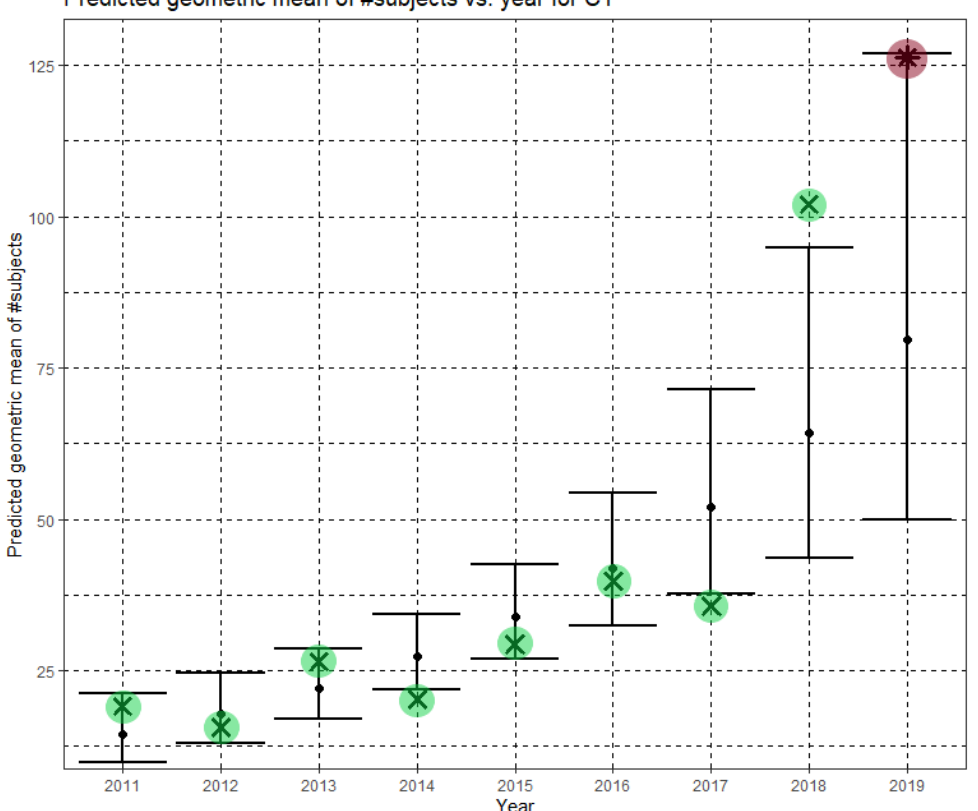
Figure 5. Phase I—Predicted geometric mean (black dots) and confidence intervals of dataset sizes in MICCAI articles involving CT for the years 2011–2019, based on the whole ensemble of 2011–2018 CT dataset sizes. The empirical geometric means (2011–2018) are shown (in green) for comparison (x marks). The empirical geometric mean for 2019 (in purple) became available later, in Phase II of this research.